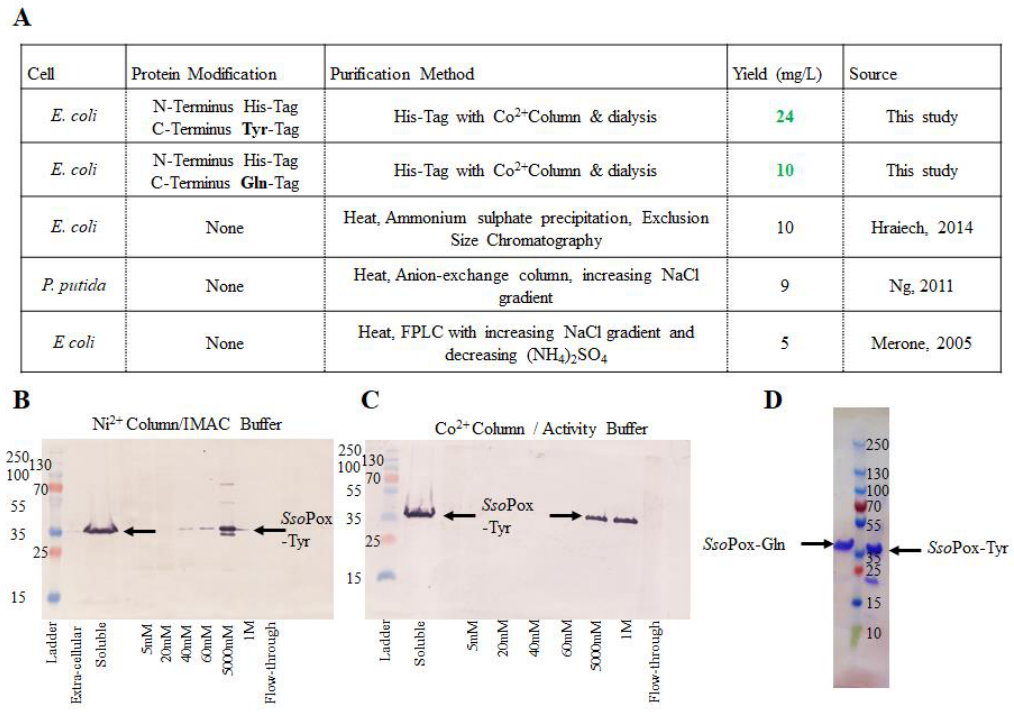
Figure 2. Purified Sso Pox-Tyr/Gln. A summary of the construction, purification and yield of the enzymes developed in this work are compared to previous work in ( A ). ( B , C ) depict representative Western blots comparing purification profiles of Ni 2+ ( B ) vs. Co 2+ ( C ) IMAC columns. In ( D )